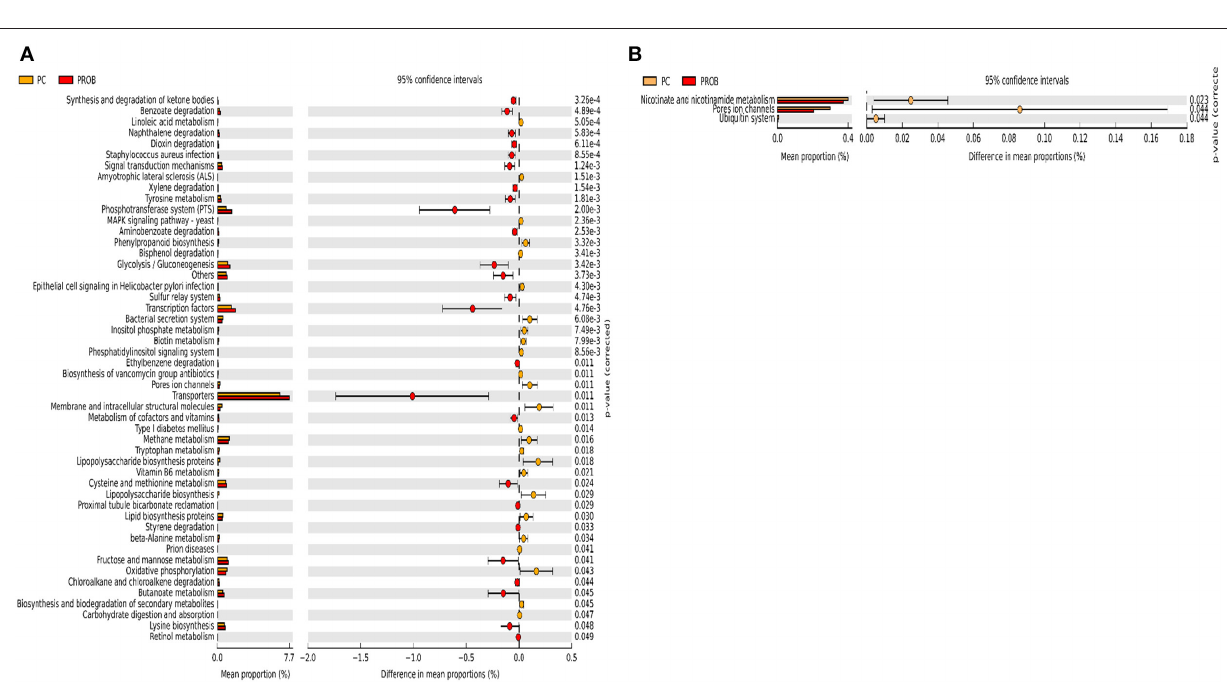
Frontiers in Veterinary Science |